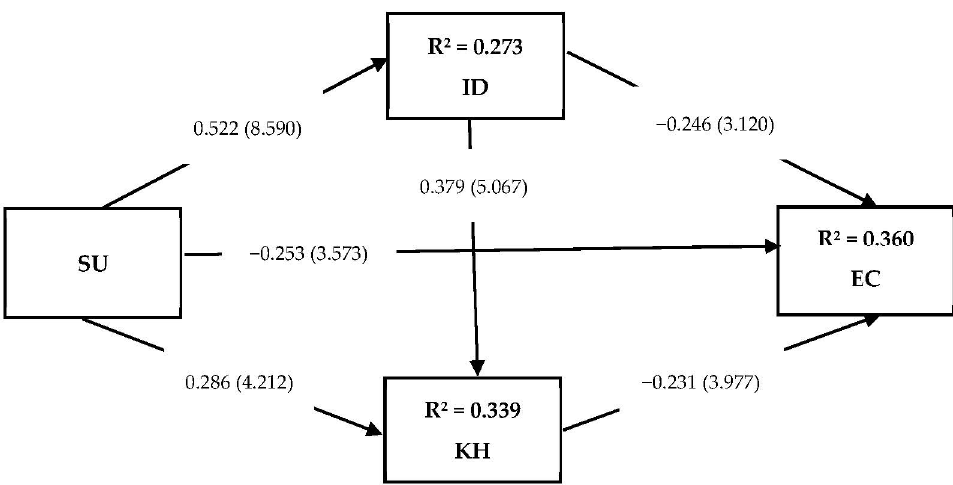
Figure 1. A serial mediation model, with t -values in